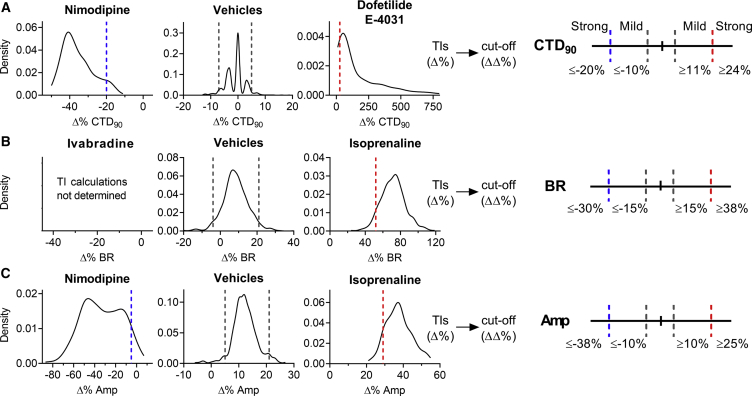
Determination of Cutoffs Using TIs to Develop the Scoring MatrixDensity plots show the TIs (dashed lines within graphs) for vehicles and positive controls to determine bidirectional cutoffs for (A) CTD90, (B) BR, and (C) Amp. TIs on vehicles were applied to aid the process of defining the no effect cutoffs. TIs (Δ%) from control drugs were corrected for vehicle offset to determine the cutoffs (ΔΔ%). Vehicle (n = 639), isoprenaline (0.1 μM; n = 357), nimodipine (0.1 μM; n = 323), E-4031 (30 nM), and dofetilide (3 nM) were combined (n = 387), ivabradine (0.1 μM; n = 6). n indicates the number of independent experiments.